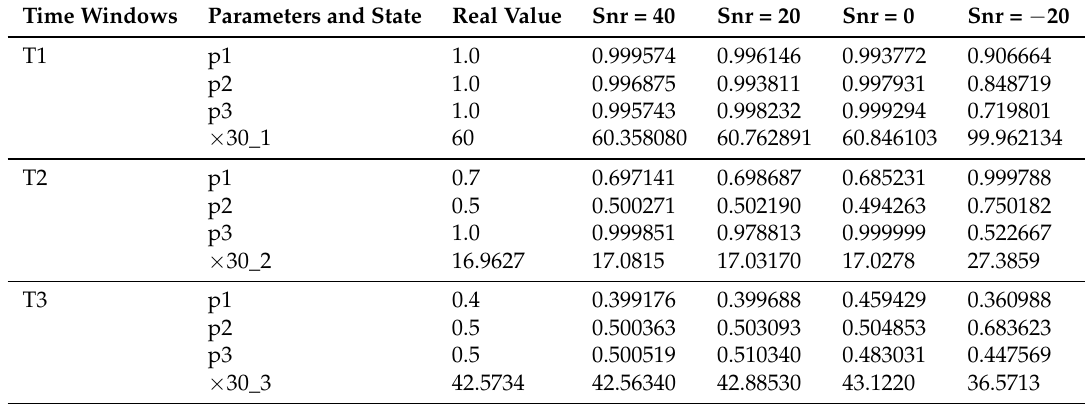
Table 2. Correlation coefficient based state estimate with different SNR in different time